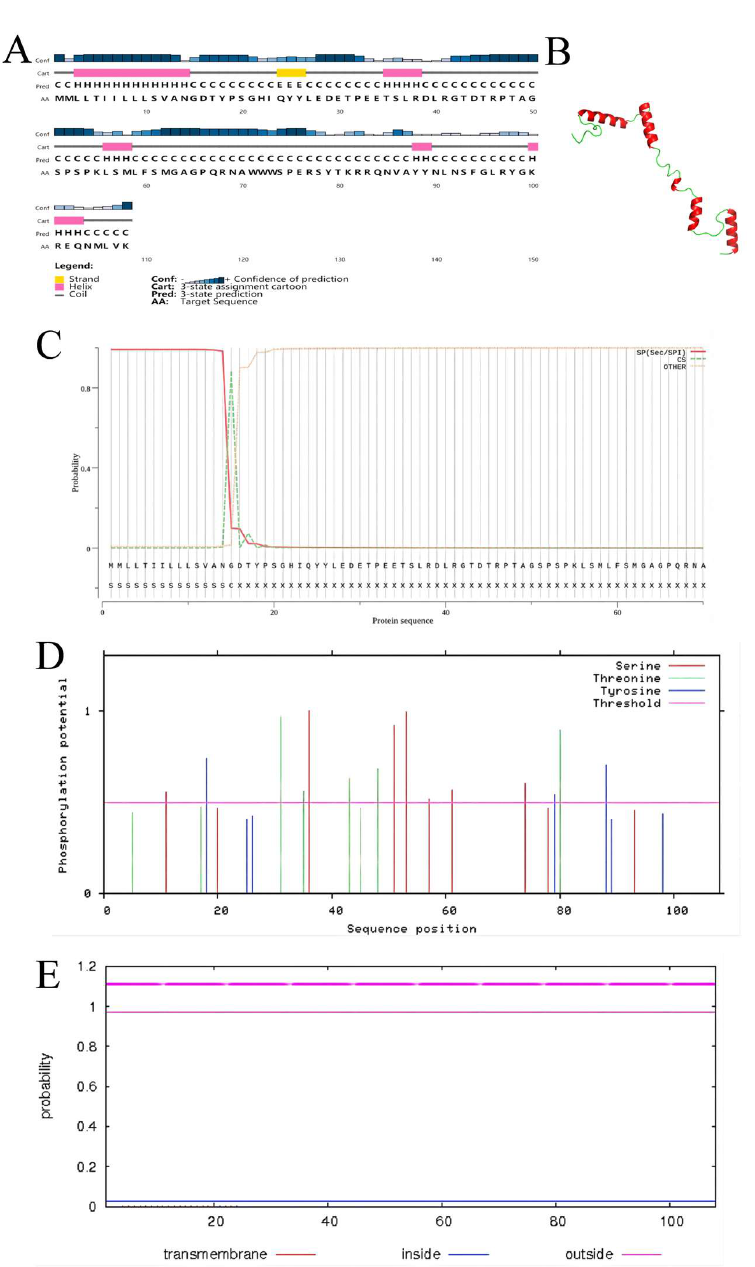
Figure 3. The characterization of kiss1 protein ( A ), Secondary structure; ( B ), Tertiary structure; ( C ), Prediction of the signal peptide; ( D ), Phosphorylation sites prediction; ( E ), Transmembrane domain